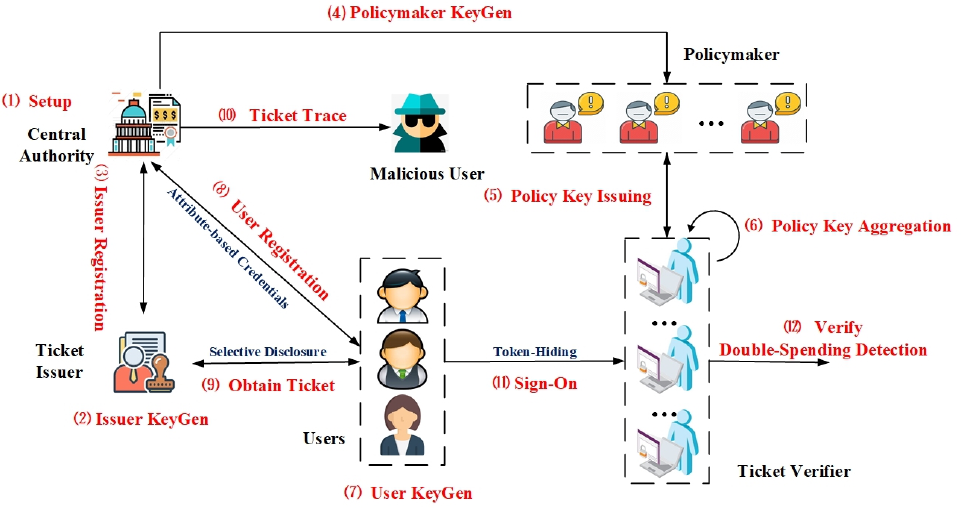
Figure 1. Architecture of